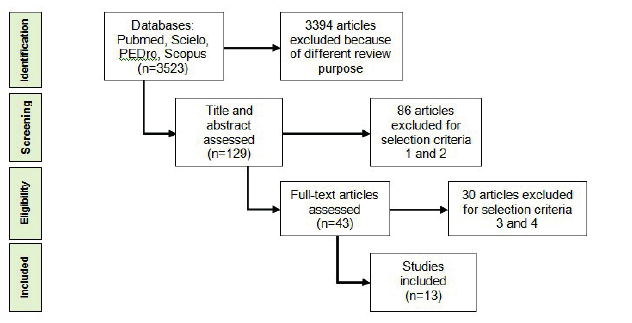
Figure 1 - Flow diagram of the literature screening process Methodological